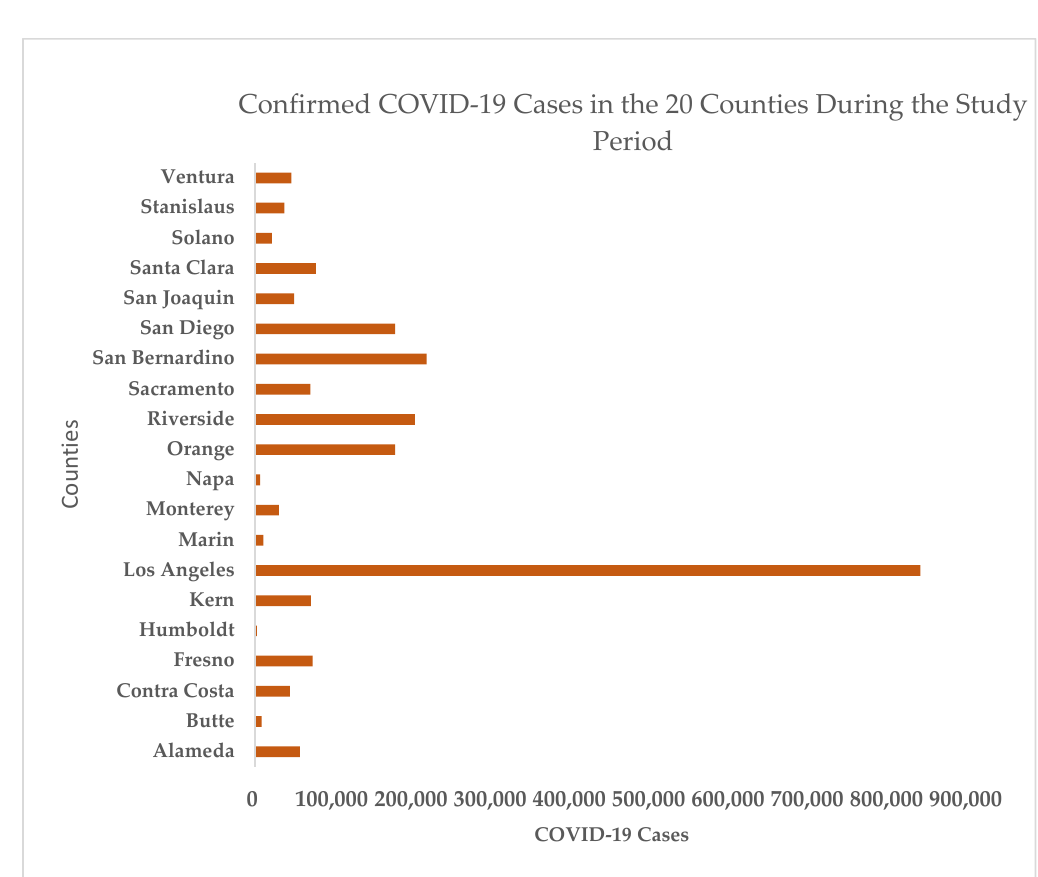
Figure A1. Confirmed COVID-19 cases in the 20 counties during the study period.